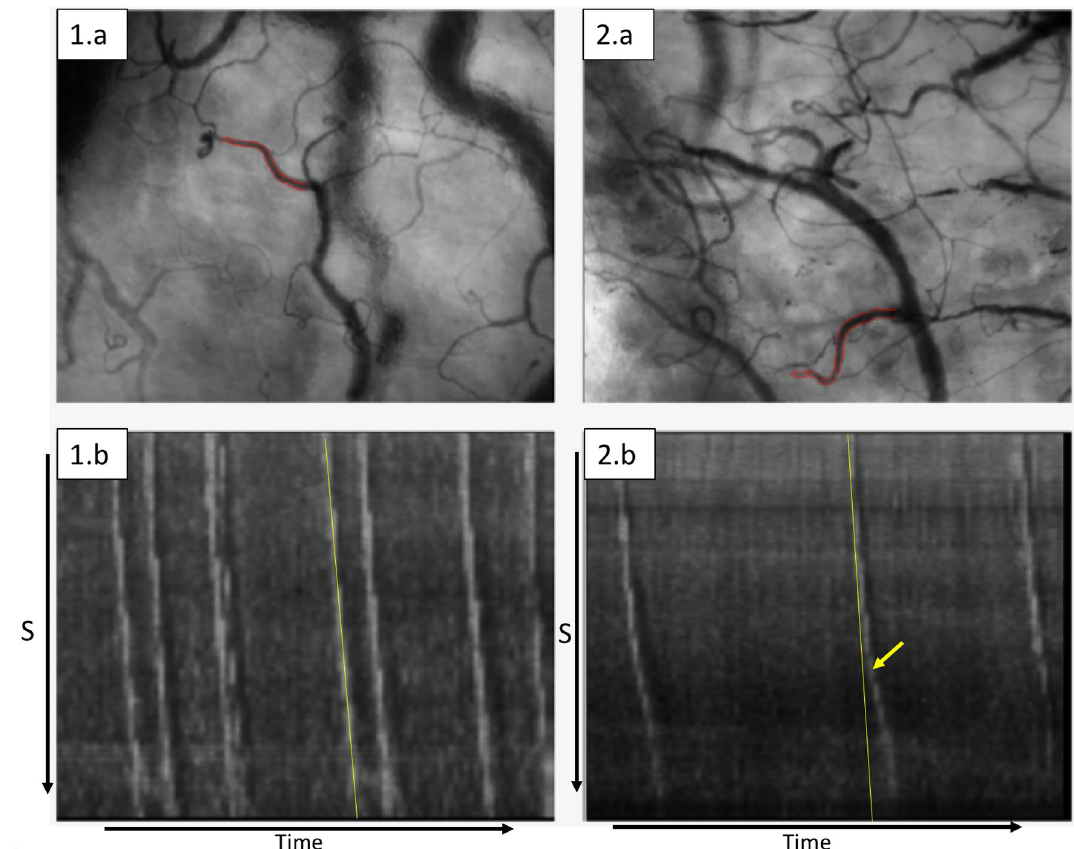
Figure 10. Screenshots of sublingual microcirculation obtained by incident dark-field imaging and examples of space–time diagrams generated from the microvascular units indicated in red in the images. ( 1.a ) Example of sublingual microcirculation. In this image, one capillary-post-capillary venule unit is shown by the redlined outlines of the vessel walls. Dimensions of the field of view of the sublingual microcirculation screenshot is 1.55 mm × 1.16 mm. ( 1.b ) Shows the generated space–time diagram of the capillary-post capillary venule. The space–time diagram shows several straight white bands, indicating non-rolling leukocytes flowing through the capillary and post capillary venule without rolling or contact with the vessel wall. The white band is a straight line, corresponding with the straight yellow, control line. ( 2.a ) Example of sublingual microcirculation. In this image, one capillary-post capillary venule unit is shown by the redlined outlines of the vessel walls. Dimensions of the field of view of this sublingual microcirculation screenshot is 1.55 mm × 1.16 mm. ( 2.b ) Shows the generated space–time diagram of the capillary-post capillary venule. The space–time diagram shows several white bands that are not straight, indicating rolling leukocytes flowing through the capillary and getting into contact with the endothelial wall in the post capillary venule part. The white band is slanted, and the straight yellow line drawn on it, does not fit the white band of this rolling leukocyte. The yellow arrow shows the start of the slanting of the white band, this is also the moment at which the white band is not straight anymore due to significant change in the velocity of the leukocyte by rolling or adherence to the endothelium. S the axis of the space–time diagram for space, Time the axis of the space–time diagram indicating the measured with a commercially available ELISA kit for Human syndecan-1 (R&D system, DY2780, Minneapolis USA). Statistical analysis. Values are expressed as mean ± SD when normally distributed (Shapiro–Wilk test), or as median [IQR] otherwise. The normal distributed dependent continuous data were compared using a Stu- dents t test for two time points or One-way analysis of variance (ANOVA) for more than two time-points, the non-normally distributed continuous data were compared using a Wilcoxon or Friedman test. Categorical data were analyzed using the Fishers-exact test. Student t test or ANOVA was performed for independent variables in normal distributed data, otherwise Mann–Whitney or Kruskal–Wallis test were used. The mixed model analysis was used if there are missing values. Correlation analysis was assessed using the Spearman rho correlation coef- ficient. A p value of < 0.05 was considered statistically significant in the present study. Statistical analysis was performed using IBM SPSS software version 24.0 [SPSS, Chicago (IL), United States] and GraphPad PRISM 8.0 (GraphPad Software, La Jolla, CA, USA).